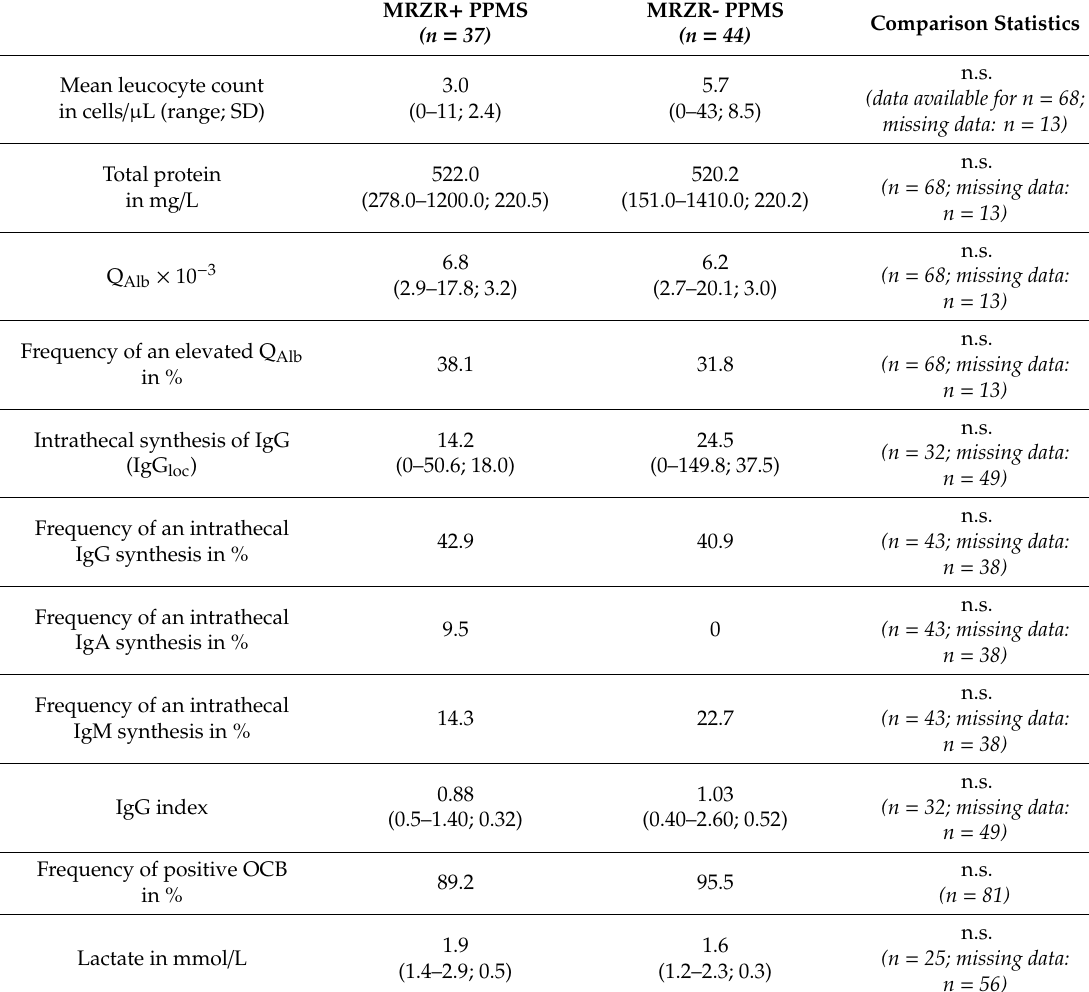
Table 2. Cerebrospinal fluid (CSF) routine